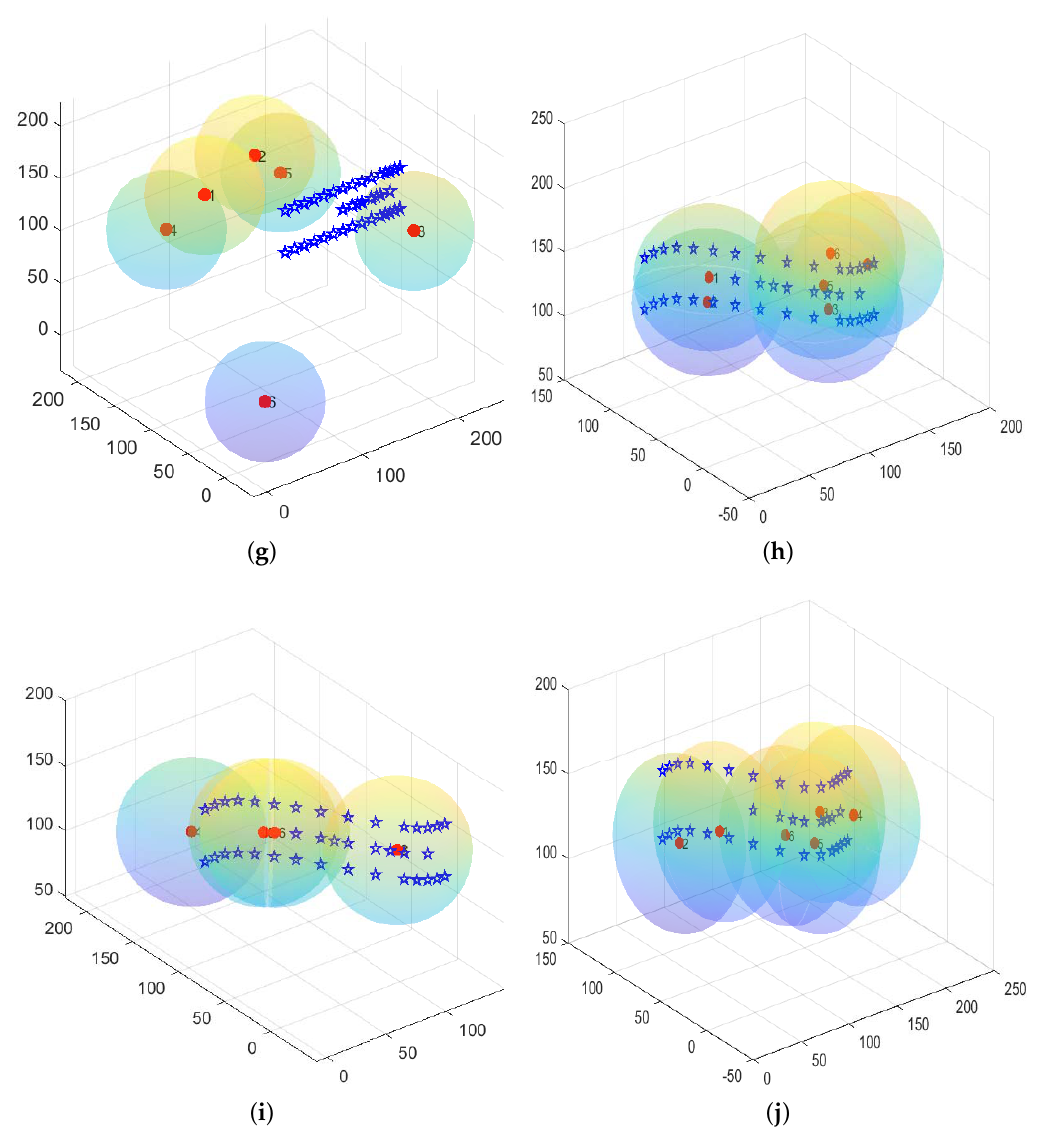
Figure 8. The distribution of sensor nodes and events at times t 1 to t 4 . ( a ) initial time node t 1 and event distribution; ( b ) initial time node t 2 and event distribution; ( c ) initial time node t 3 and event distribution; ( d ) initial time node t 4 and event